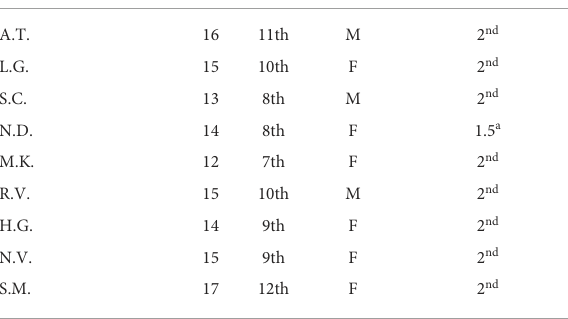
TABLE 1 Demographic characteristics of interview